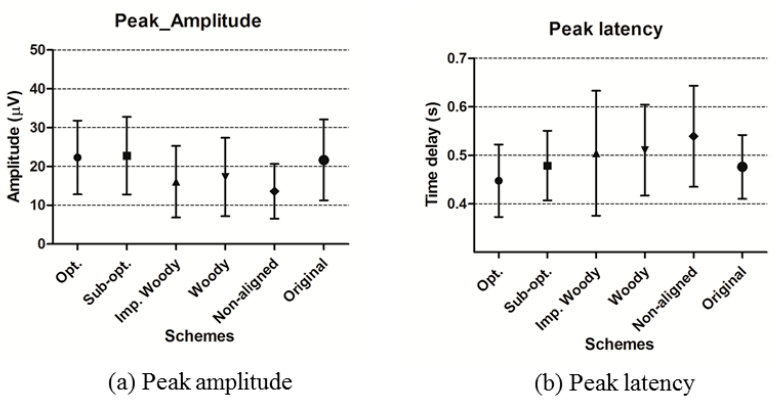
Figure 7. Statistical analysis of ERP characteristic in time domain. ( a ) Peak amplitude; ( b ) Peak latency analysis result with 15 subjects.